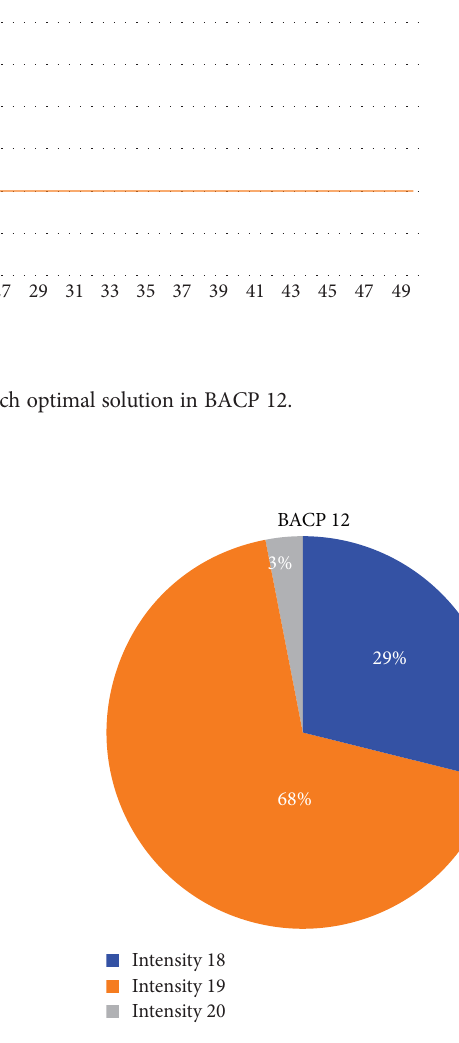
F IGURE 9: BACP 12 result distribution with local search mechanism.